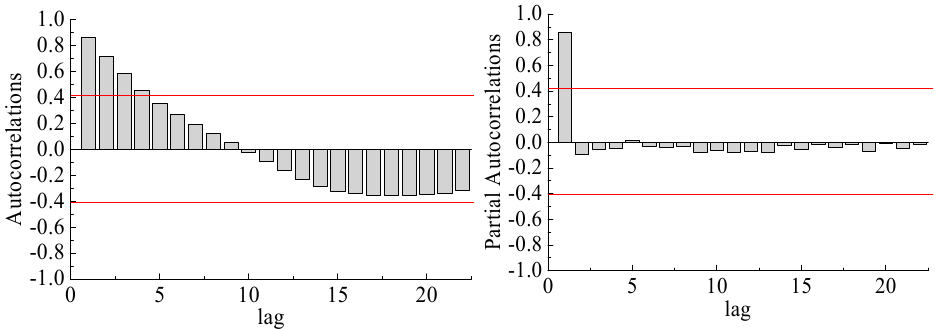
Figure 3. Autocorrelation coefficient and partial autocorrelation coefficient of the pit gain time series. Table 1. Unit root test results of the pit gain time series. τ Statistics